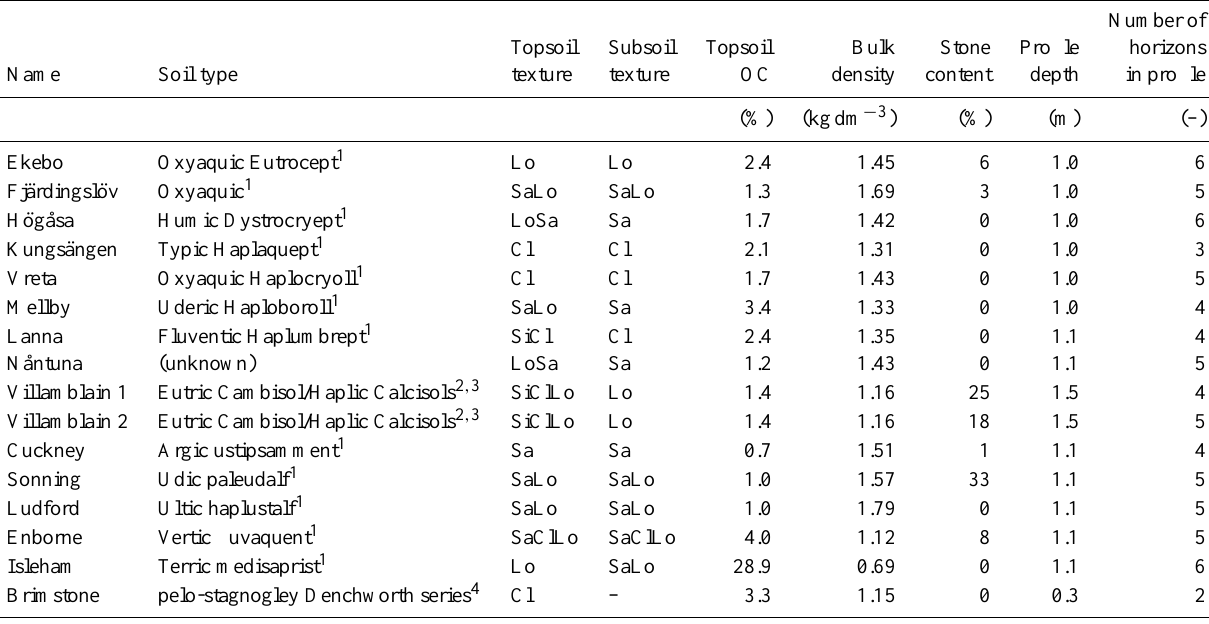
Table 2. Characteristics of the different soils. Texture classes are given according to the USDA system (“Cl” = “Clay”, “Si” = “Silt” or “Silty”, “Sa” = “Sand” or “Sandy” and “Lo” = “Loam” or “Loamy”). Texture, organic carbon, bulk density and stone content values are the average values of the different layers concerned weighted by their